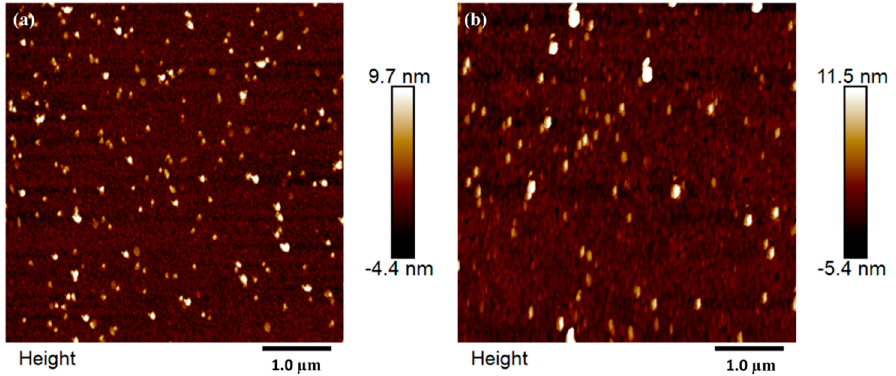
Figure 3. AFM images in a scan area of 5 × 5 μ m 2 of the TiHfN/Si samples: ( a ) as-deposited and ( b ) annealed films.